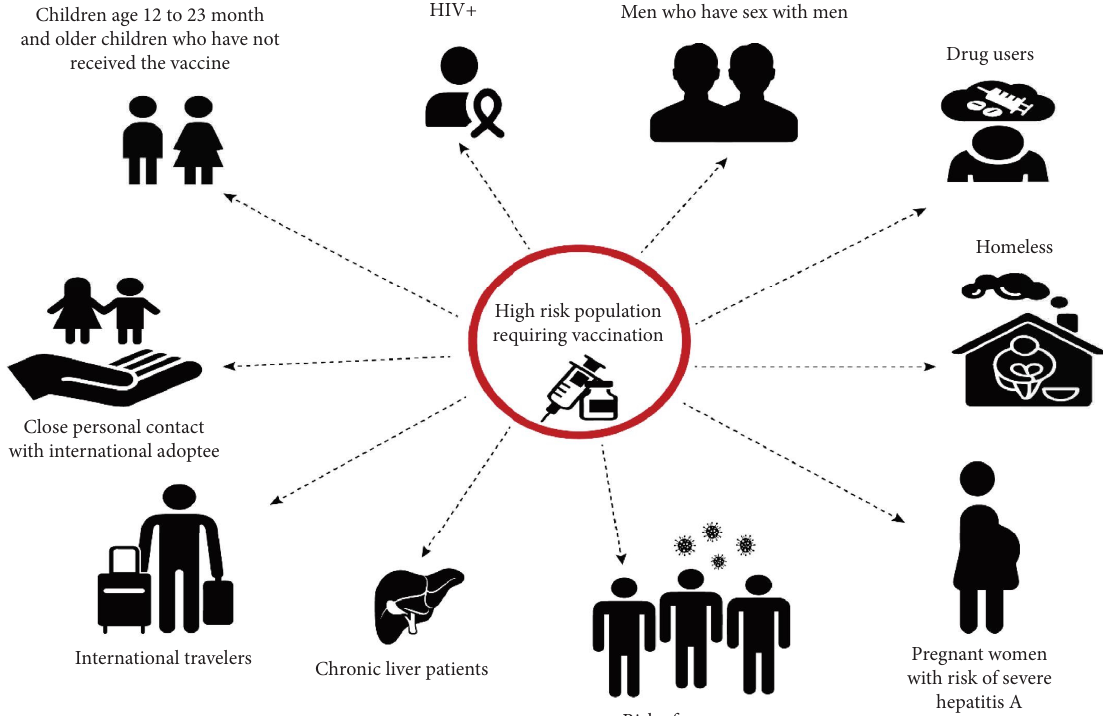
Figure 4: Te Centers for Disease Control and Prevention (CDC) recommend hepatitis A vaccination for diferent groups of populations, including one-year-old children, all children and teens up to age 18 who have not previously been vaccinated, certain children aged 6–11months who are traveling outside of their countries, all adults who are at risk, or adults who do not have a risk factor but want to avoid hepatitis A